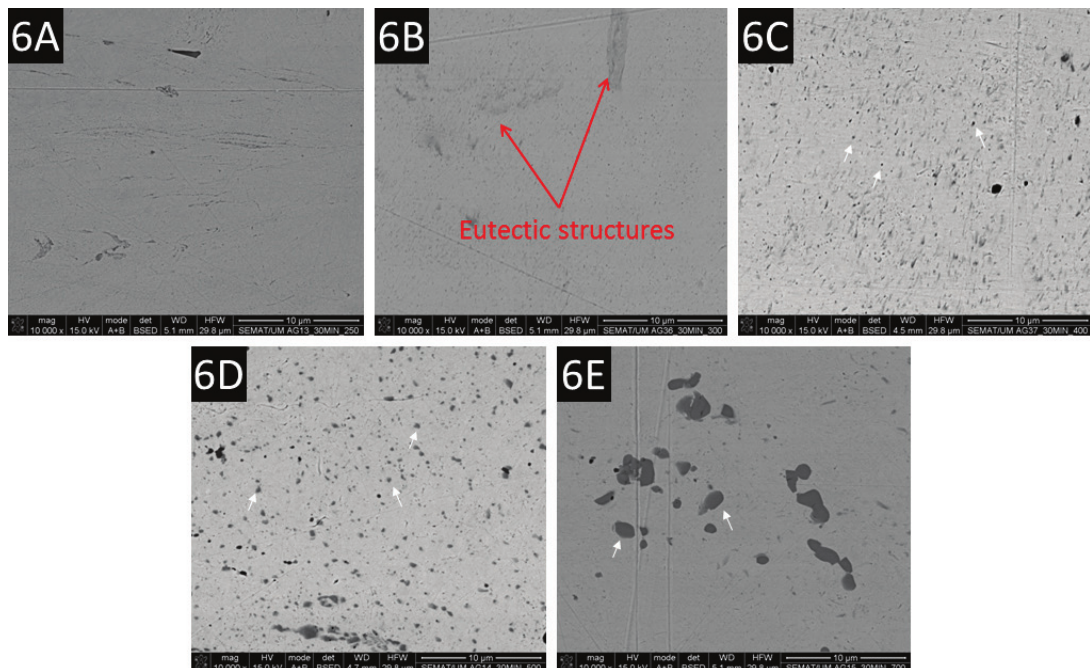
Figure 6. SEM micrographs of hot pressed sterling silver compacts processed at a pressure of 35MPa for 30min at different temperatures: A) 250 °C; B) 300 °C; C) 400 °C; D) 500 °C and E) 700 °C. White arrows indicate the Cu-rich precipitates ( β phase).